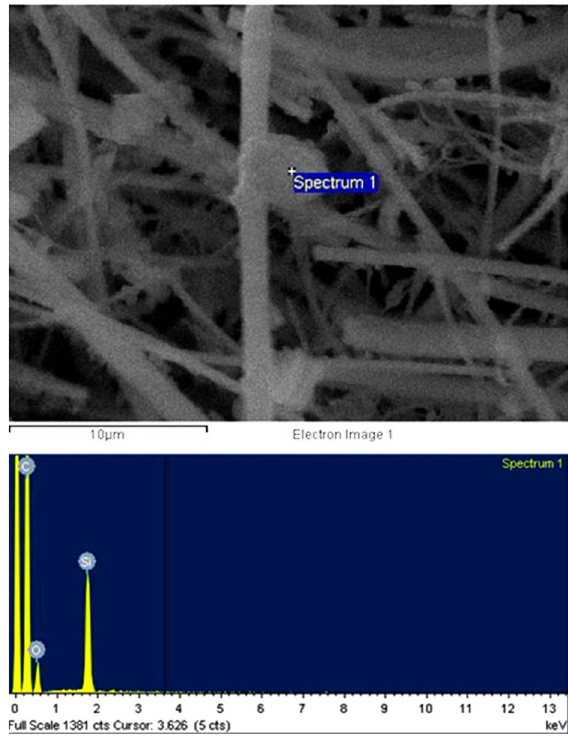
Figure 6. SEM micrograph and EDS spectrum of sphere-like